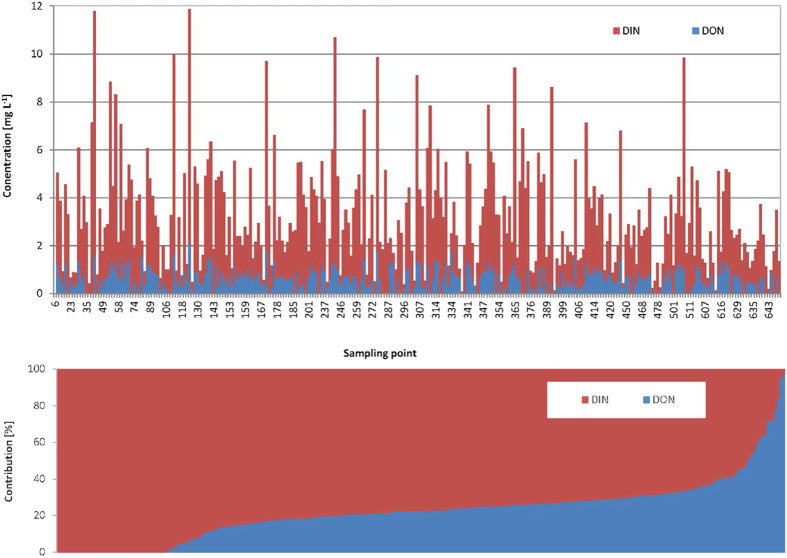
(top) Absolute concentrations of DIN and DON [mg l−1] per sample point; (bottom) contribution [%] of DIN and DON across the stream cohort of the HydroCrowd experiment.